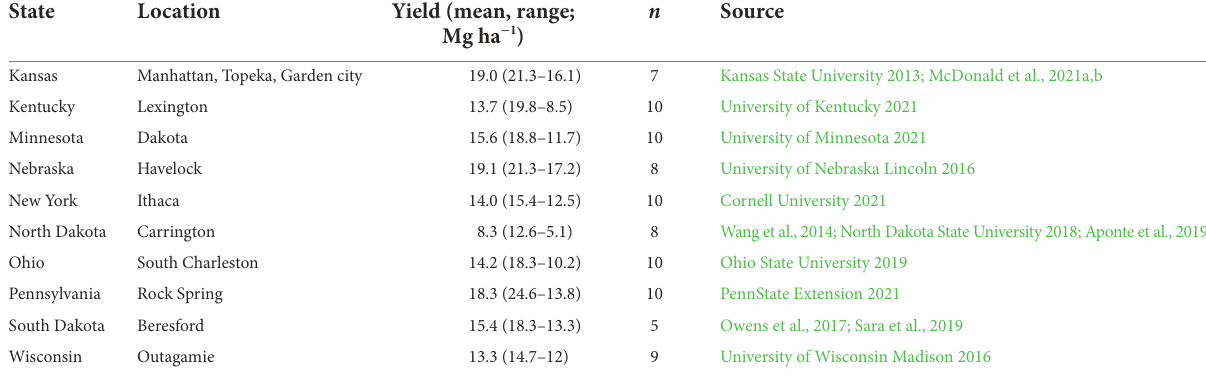
TABLE 1 Mean and range in alfalfa forage yield as reported by various field experiments during the study period